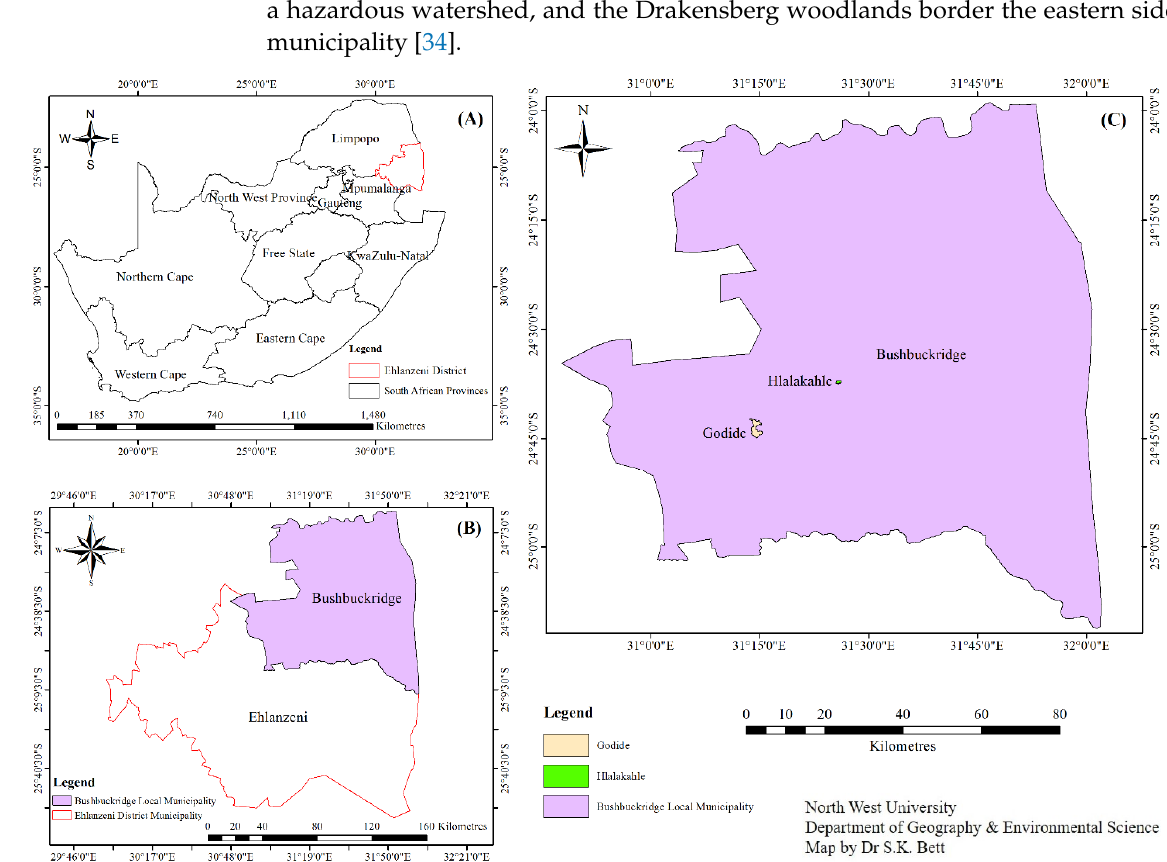
Figure 1. Study sites in Mpumalanga Province, South Africa ( A ) South Africa; ( B ) Ehlanzeni district and ( C ) selected communities in Bushbuckridge.